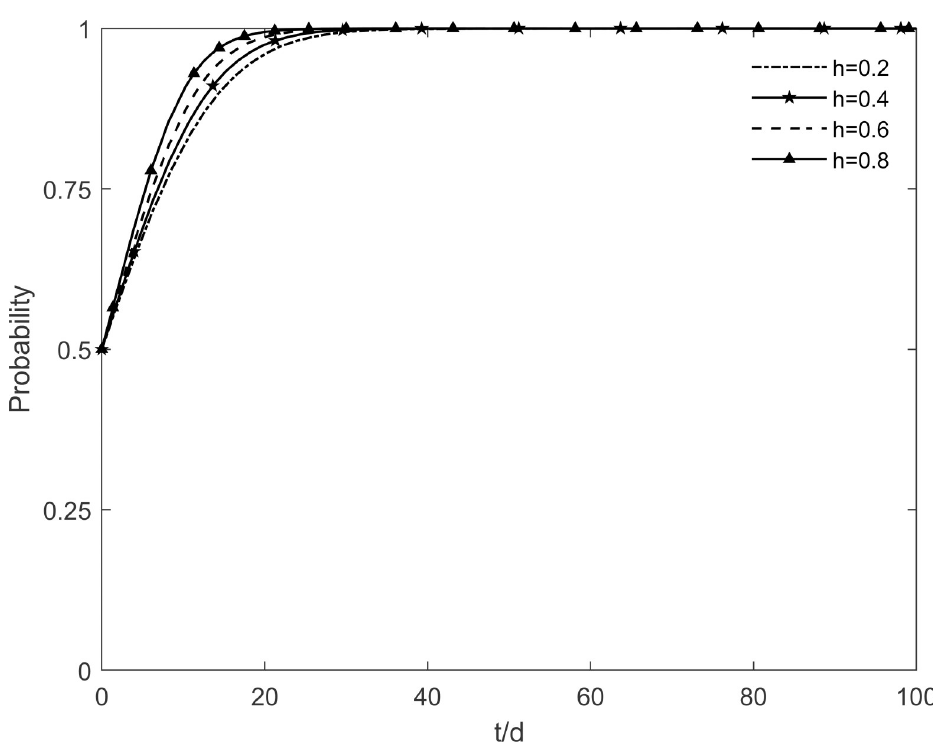
Fig 5. The impact of h on residents’ strategic